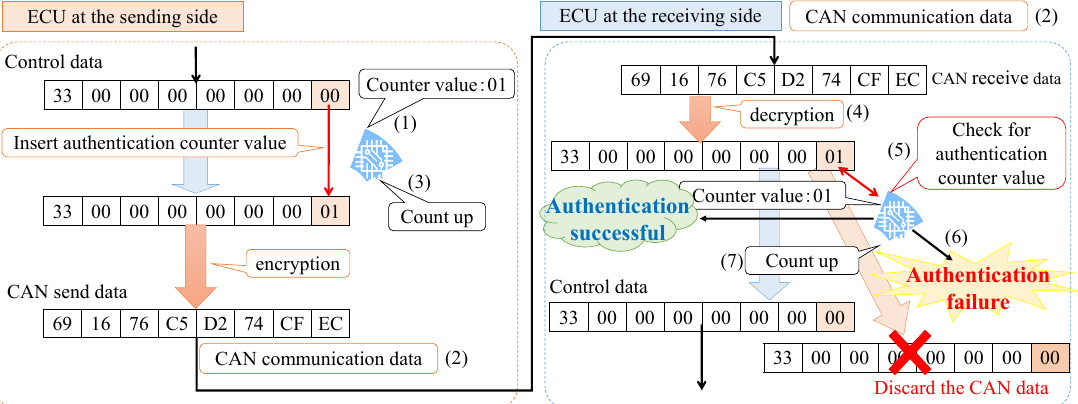
Fig. 5. Proposed authentication